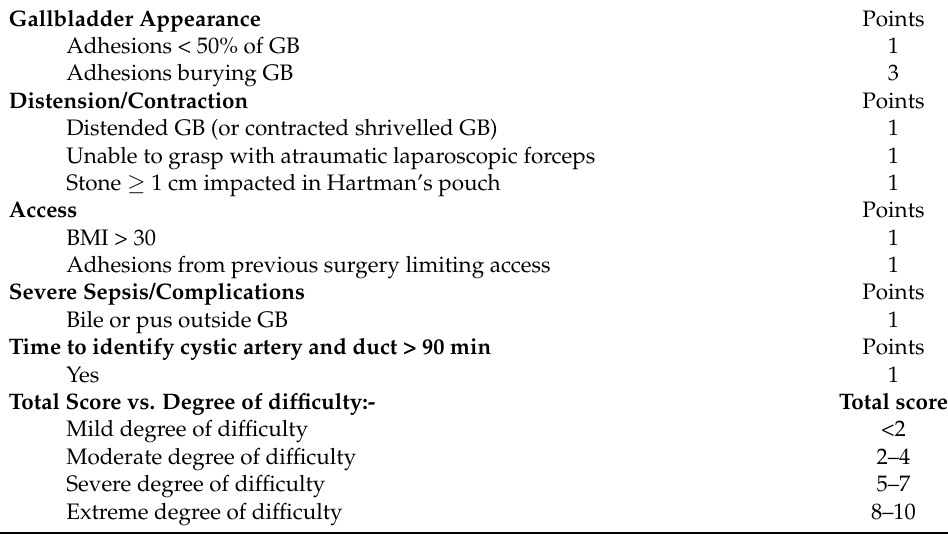
Table 7. Post-operative grading system for cholecystitis